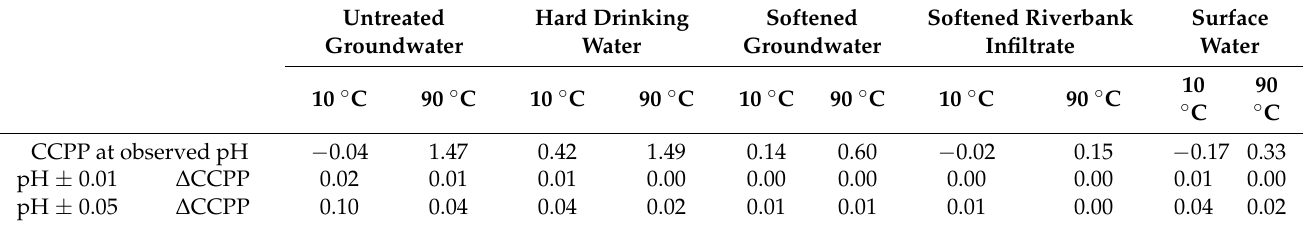
Table 5. Effect of varying pH ( ± 0.01 and ± 0.05) on CCPP 10 ◦ C and 90 ◦ C. Untreated groundwater: Frederiksberg. Hard drinking water: Thorsbro. Softened drinking water: Brøndbyvester. Softened riverbank infiltration: Lekkerkerk. Surface water: Ülemiste. The unit is mmol/kg.